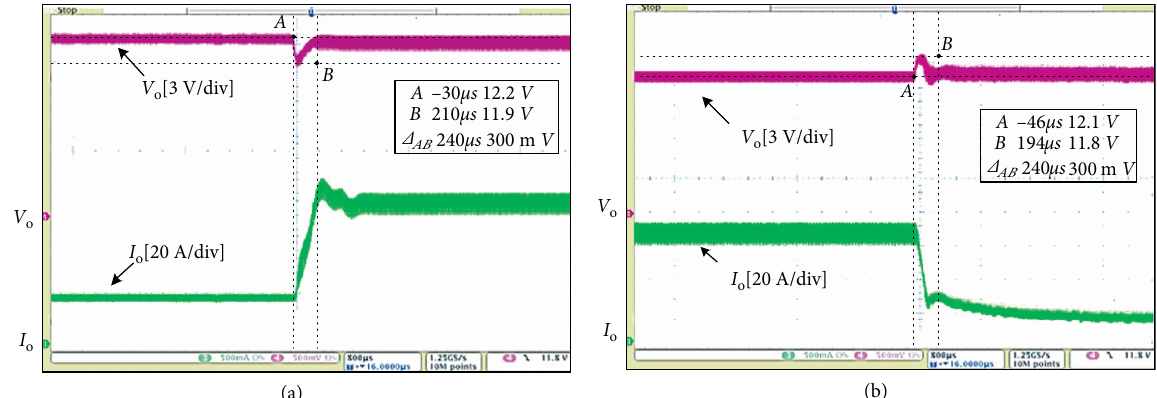
Figure 17: The soft-switching waveform comparison of lagging arm 𝑄 and (b) 𝑇 d =2 μ s.